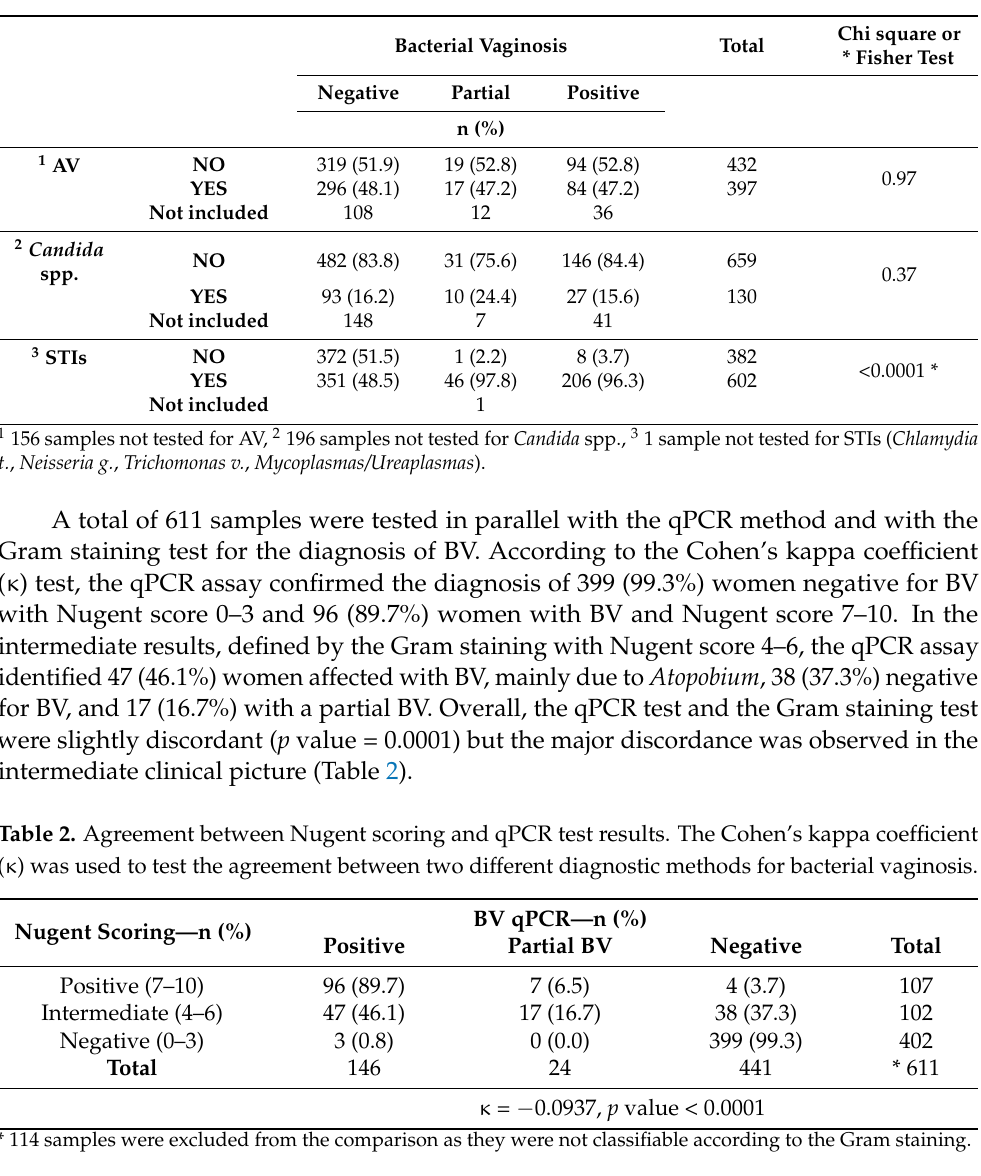
Table 1. Association between the diagnosis of bacterial vaginosis, based on qPCR test, and the presence of co-infections.